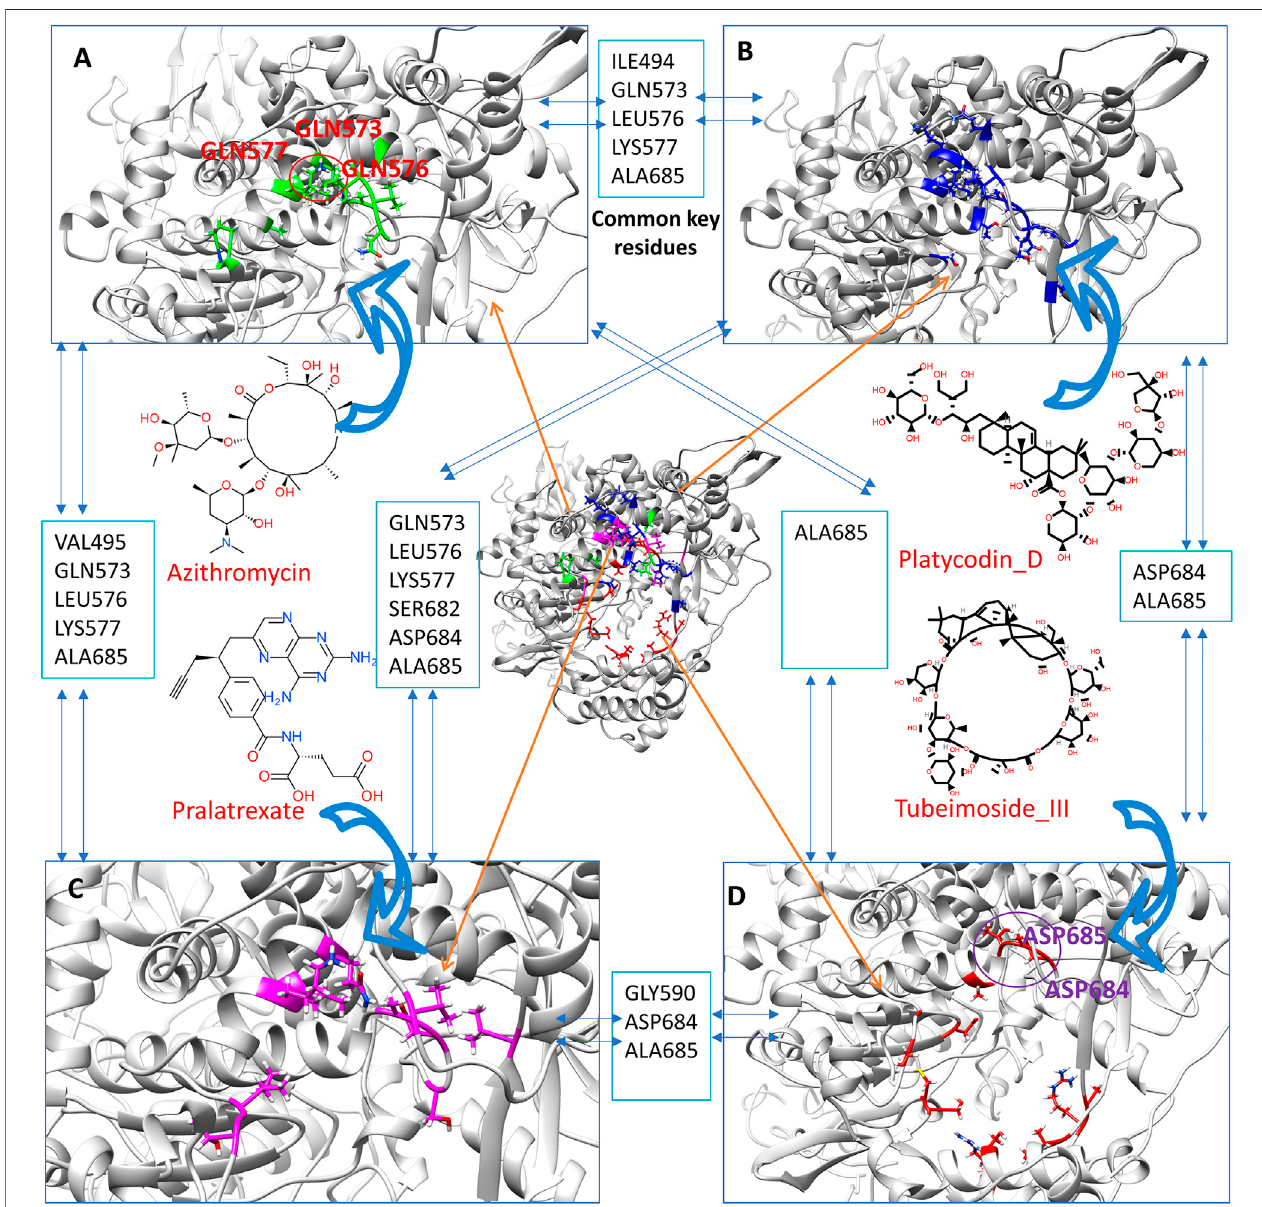
FIGURE5| Theclosecontactresidues(within0.5 nm)ofthefouractiveinhibitorsfromtheirlastframeofMDsimulation.TheclosecontactresiduesofAzithromycin ( A , residue with green), Platycodin_D ( B , residues with green), Pralatrexate ( C , residues with magenta), and Tubeimoside_III ( D , residues with magenta). The common key residues between each of these compounds ’ close contact residues are also listed.